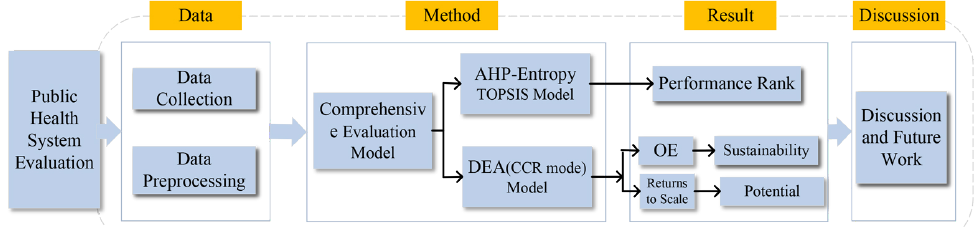
Figure 1. The overall flowchart of the modeling and